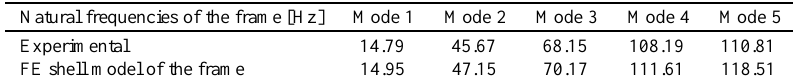
Table 2 Experimental vs. theoretical natural frequencies of the frame using shell